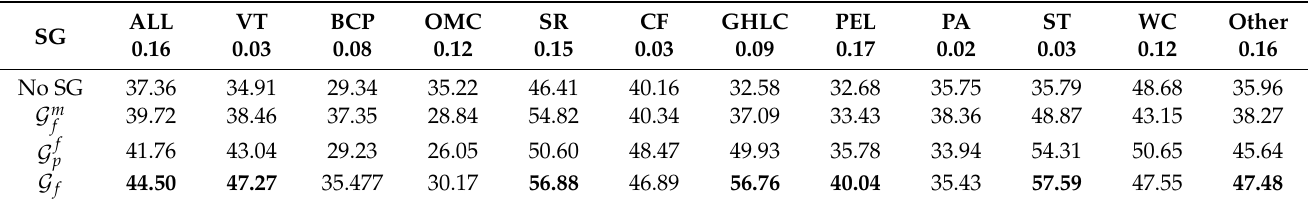
Table 5. The influence of semantic graphs on the 11 types of questions in the OK-VQA